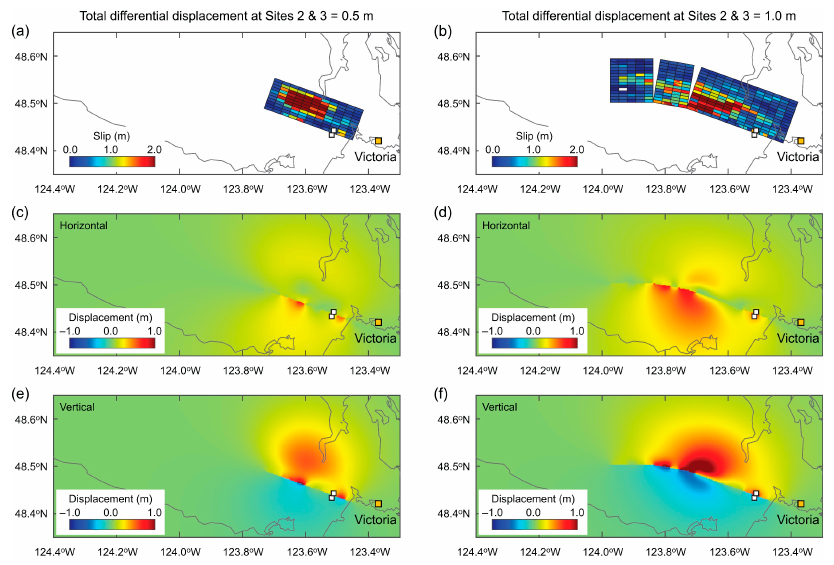
Figure 12. Regional views of earthquake slip distribution ( a , b ), horizontal displacement ( c , d ), and vertical displacement ( e , f ) due to stochastic source models that produce total differential displacements of 0.5 m ( a , c , e ) and 1.0 m ( b , d , f ) for Sites 2 and